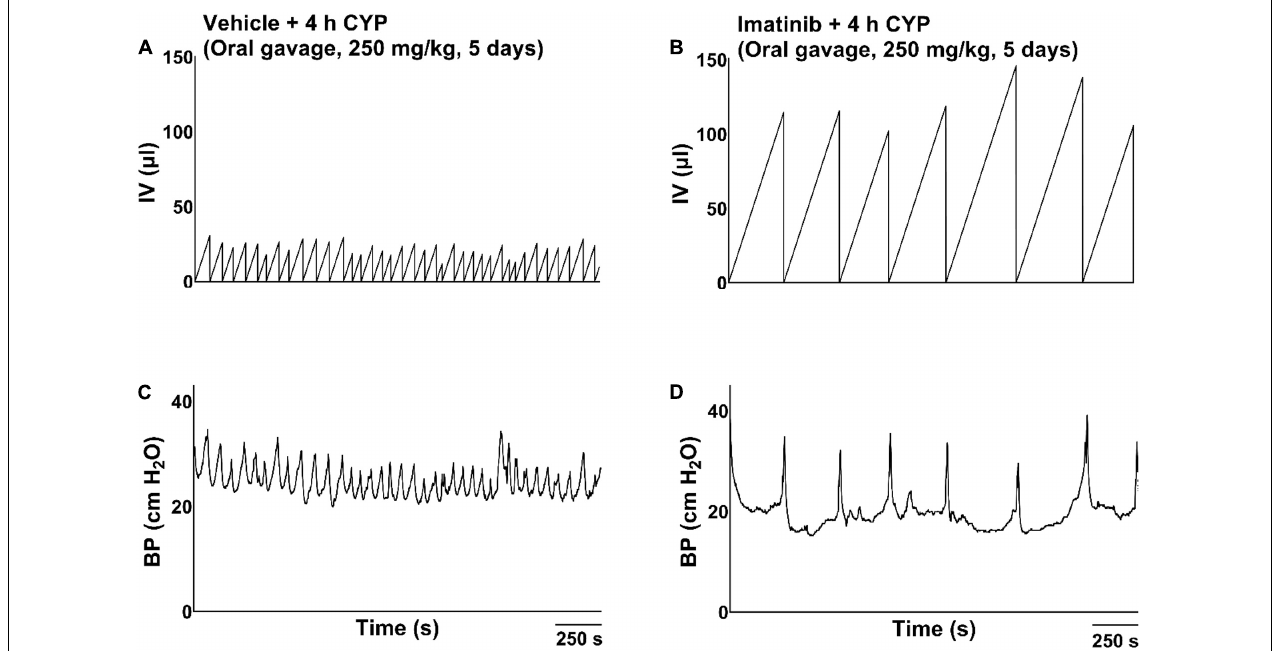
FIGURE 3 | Representative bladder function cystometry recordings from female mice with acute CYP-induced cystitis, pre-treated with imatinib mesylate or vehicle via oral gavage. (A,B) Mice with 4 h CYP-induced cystitis (200 mg/kg, 4 h, i.p.) pre-treated with vehicle exhibited significantly decreased IMI ( p ≤ 0.001) and IV ( p ≤ 0.0001), compared to control mice. (C,D) Mice with 4 h CYP-induced cystitis pre-treated with imatinib (250 mg/kg, 5 days, 1X/day) exhibited significantly ( p ≤ 0.001) increased IMI and IV, compared to mice with 4 h CYP-induced cystitis pre-treated with vehicle. Recordings are from separate cohorts of mice. n = 5–9. By two-way ANOVA with Bonferroni’s multiple comparisons test. CMG, cystometrogram; BP, bladder